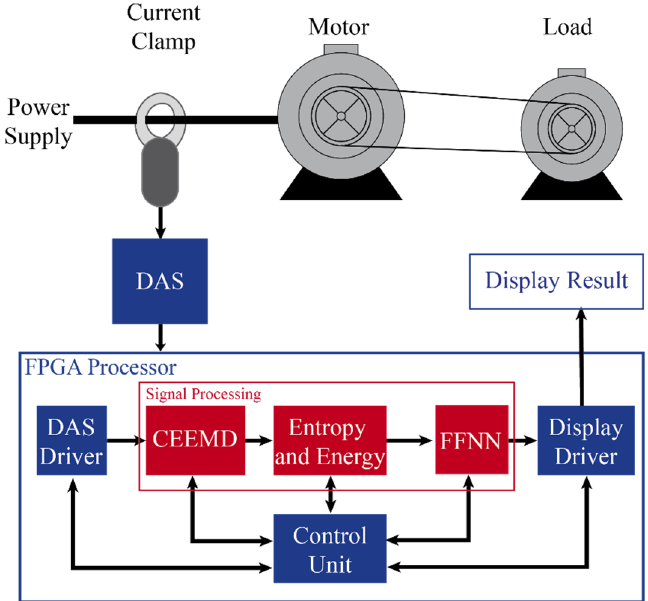
Figure1. Proposedmethodologyforfaultdiagnosisininductionmotors. DAS—data-acquisitionsystem; Figure 1. Proposed methodology for fault diagnosis in induction motors. DAS—data-acquisition FPGA—field programmable gate array; CEEMD—complete ensemble empirical mode decomposition; system; FPGA—field programmable gate array; CEEMD—complete ensemble empirical mode FFNN—feed forward neural decomposition; FFNN—feed forward neural network.